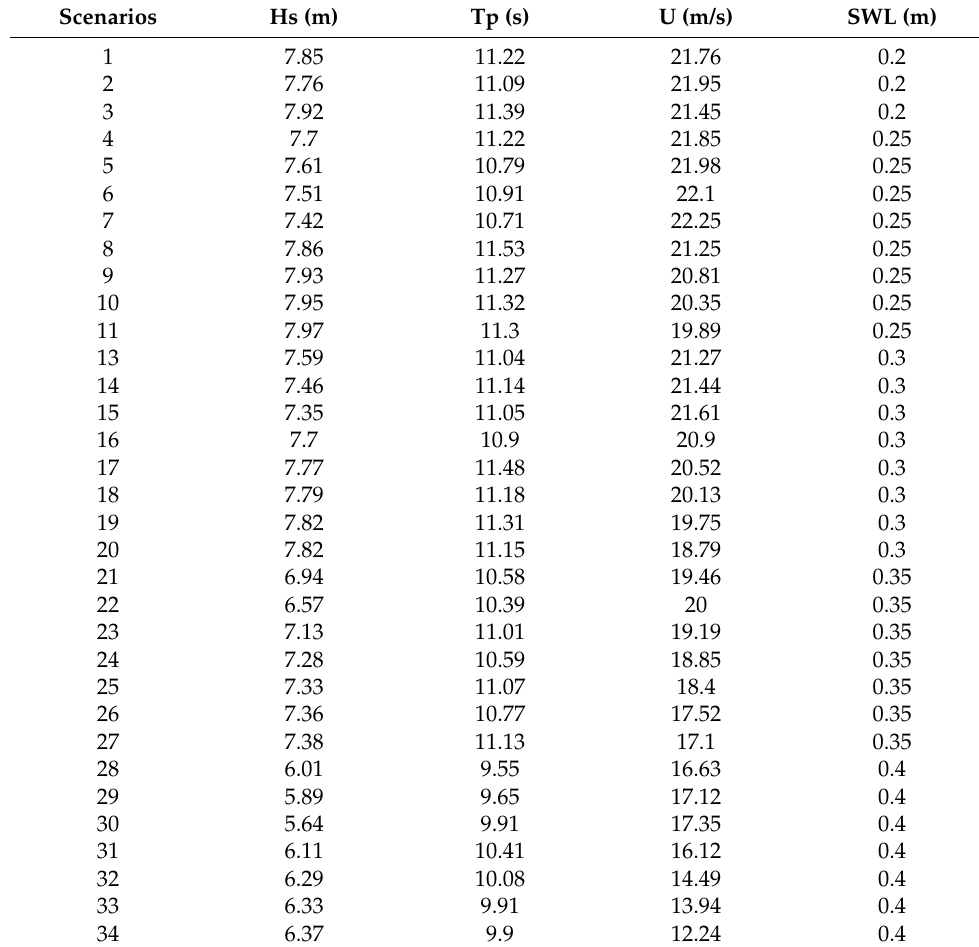
Table 2. Combinations Hs, Tp, U, and SWL selected from the Gulf of Porto case. Scenarios